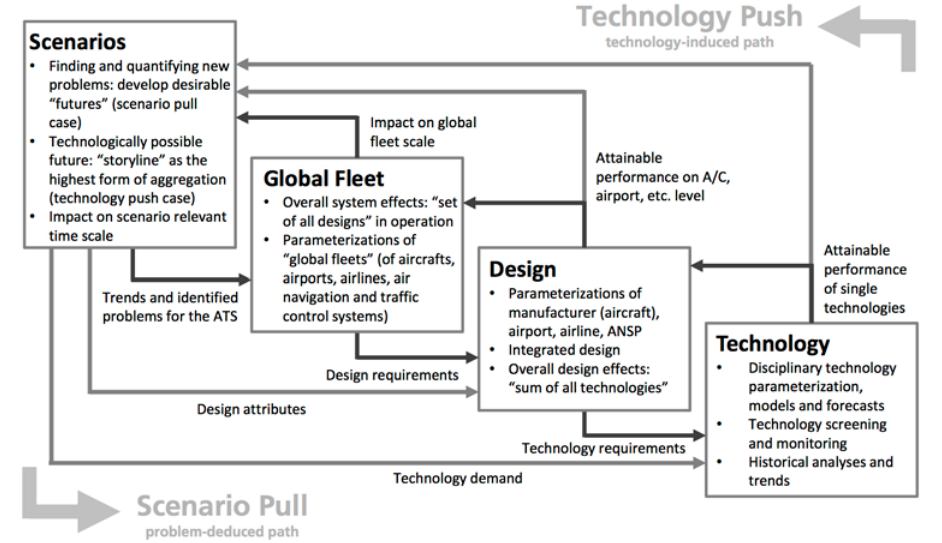
Fig. 8. Project development strategies. From (Gosh